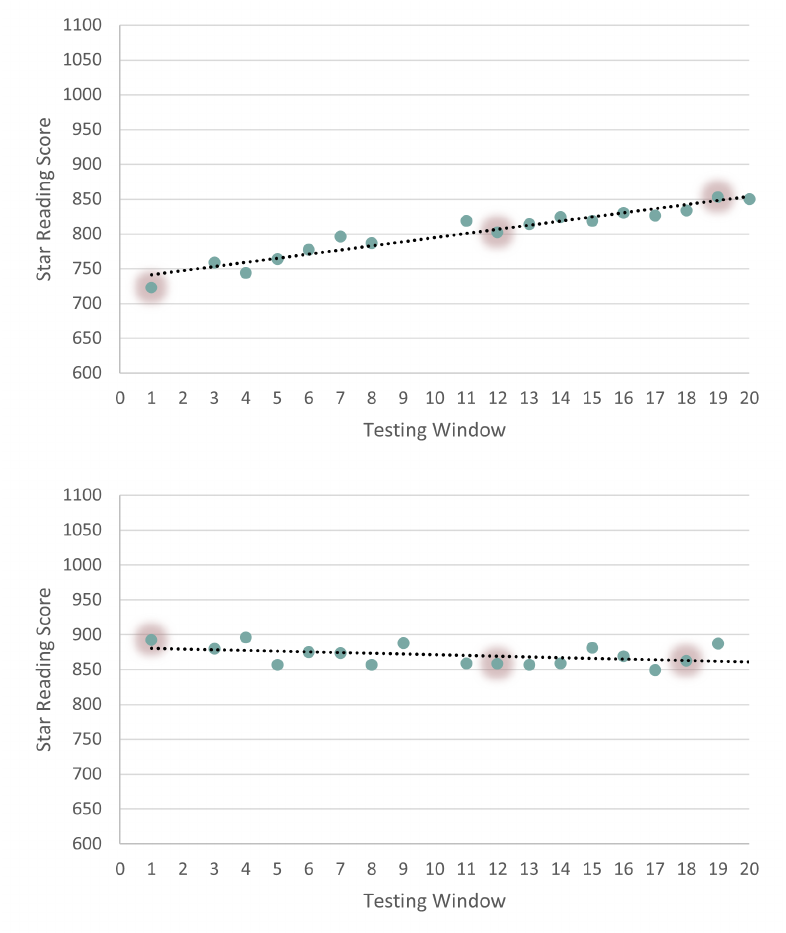
Figure 6. Original and recommended test administrations for two